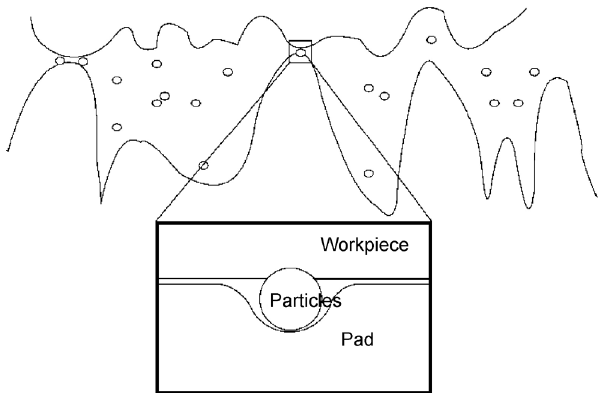
Fig. 3 CMP material removal model.